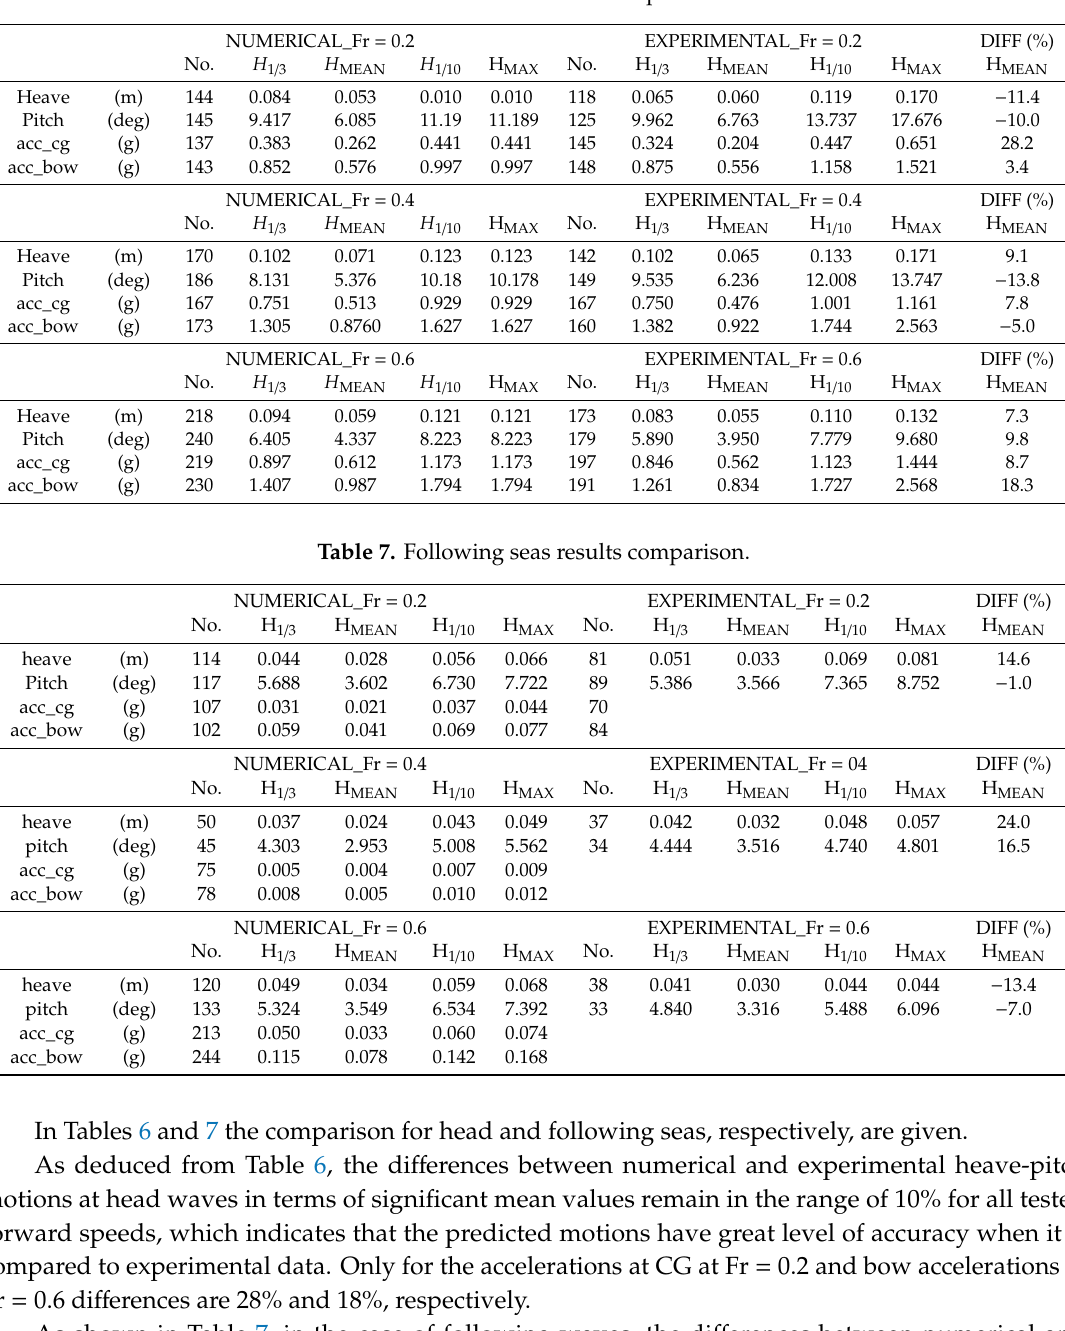
Table 6. Head seas results comparison.